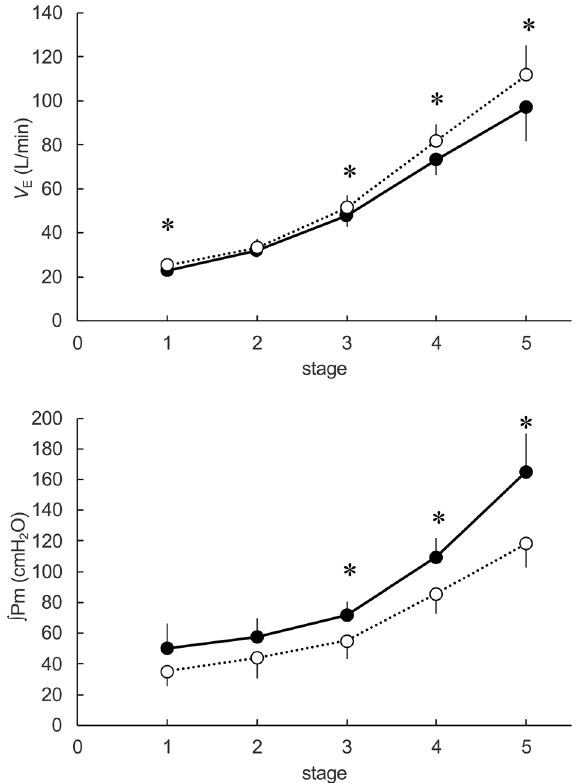
Figure 2. Minute ventilation and respiratory effort during incremental running test. The data show the minute ventilation ( V E , upper panel) and minute integral of the mouth pressure (∫pm, lower panel). The black circles represent the cloth face masked (CFM) condition. The white circles indicate the unmasked control (CON) condition. There was a significant interaction (mask × stage) for both V E ( P = 0.01, pη 2 = 0.47) and ∫pm ( P = 0.01, pη 2 = 0.51). *, P < 0.05, between the FM and CON conditions in the post hoc